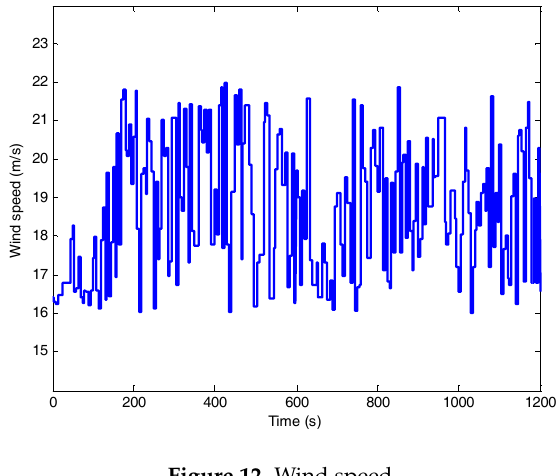
Figure 12. Wind speed.